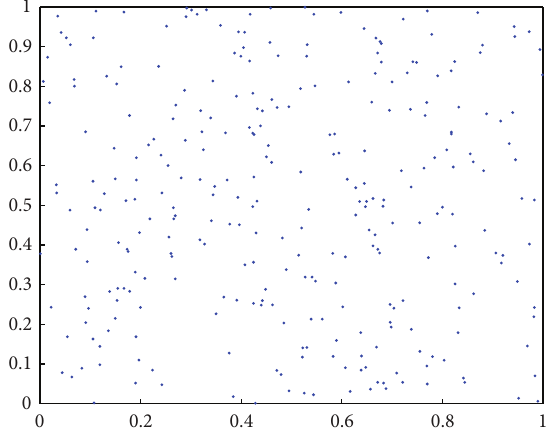
Figure 4: 300 scattered points randomly selected in [0,1] × [0, 1] . Figure 5: Delaunay triangulation based on Figure 4.